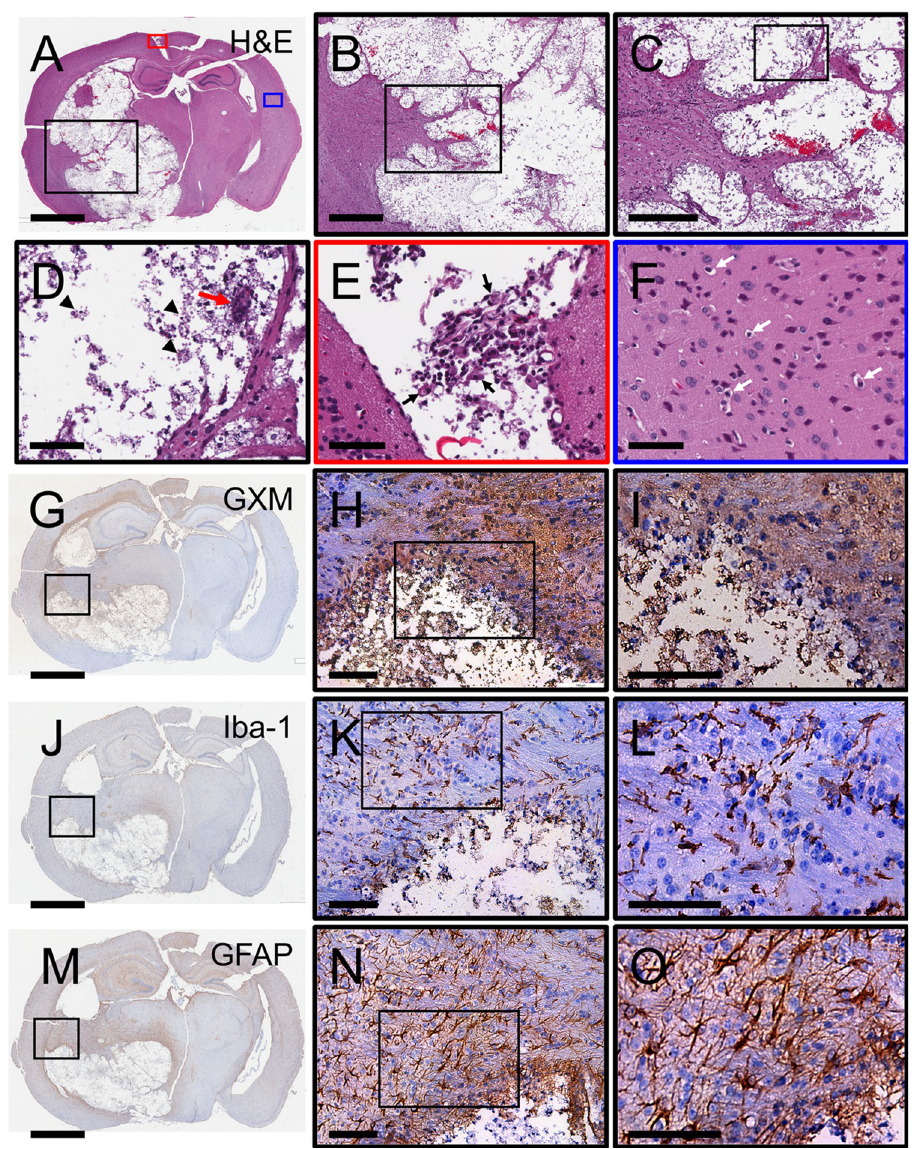
Fig 4. Cerebral cryptococcosis in mice infected in the corpus striatum of the basal ganglia. Representative coronal brain sections (scale bar: 1 mm) of striatal-infected mice stained with (A-D) H&E, (G-I) GXM-specific mAb 18B7, (J-L) Iba-1 (microglia), and (M-O) GFAP (astrocytes) are shown after tissue excision 20-dpi. (D) Arrow heads denote vacuolated macrophages or hueco cells. Red arrow indicates foreign body giant cell. (E) Red and (F) blue boxes are a magnification (scale bar: 100 μ m) of specific regions of the brain in A . Black arrow in E show activated macrophages or epithelioid cells. White arrows in F denote perivascular edema and ischemic neurons. Middle ( B , H , K , N ; scale bar: 100 μ m) and right ( C , I , L , O ; scale bar: 20 μ m) panel images are a magnification of the smaller box in the corresponding left-stained section to better show the tissue morphology, GXM distribution (brown stain), and glial cell recruitment/activation (brown stain). Five mice per infection route were evaluated to confirm all the histopathological observations reported in these studies. (Fig 5B). A high magnification image demonstrates minimal inflammation and the presence of a megakaryocyte (blue arrow) that is indicative of thrombosis (Fig 5C). Ventricle-infected tissue demonstrated extensive distribution of GXM in regions such as the cerebral cortex, meninges, basal ganglia, and corpus callosum (Fig 5D). GXM was concentrated in the frontoparietal cortex